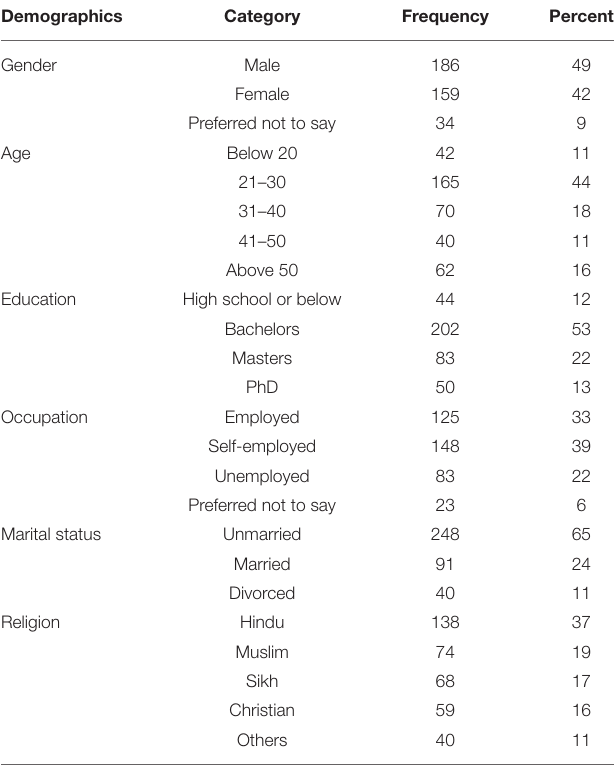
TABLE 2 | Demographic profile of